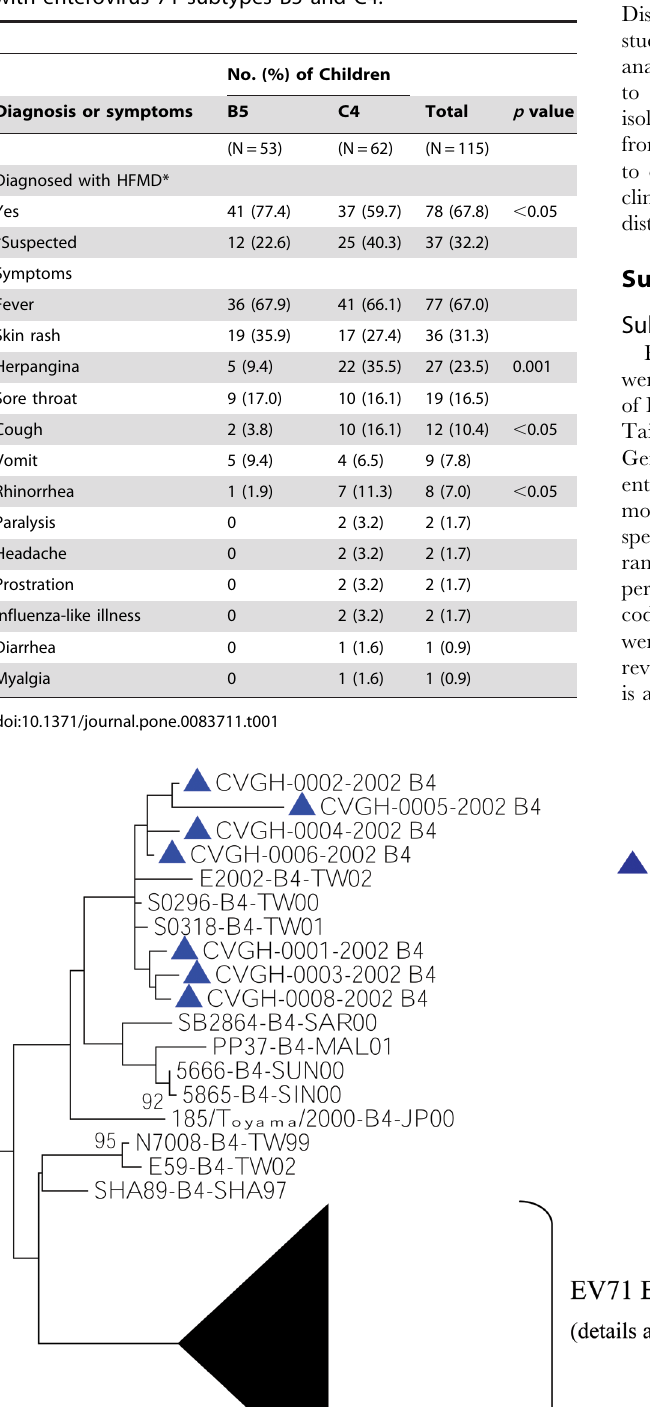
Table 1. Comparison of the diagnosis of hand-foot-mouth disease and symptoms and signs between patients infected with enterovirus 71 subtypes B5 and C4.